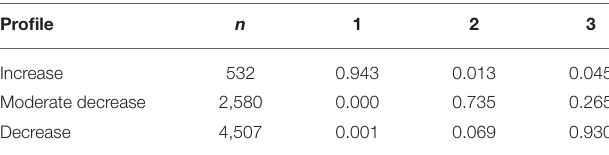
TABLE 2 | Average latent class probabilities for most likely latent class membership (row) by latent class